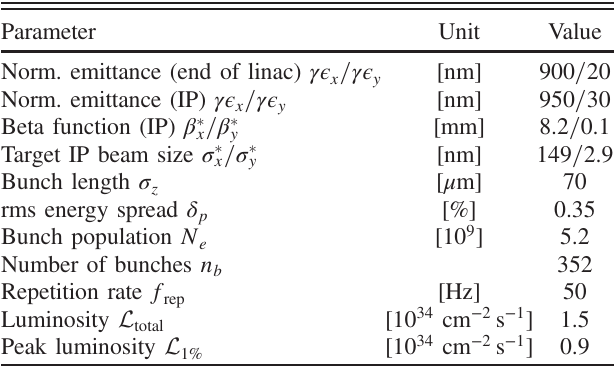
TABLE I. CLIC 380 GeV beam parameters. Parameter